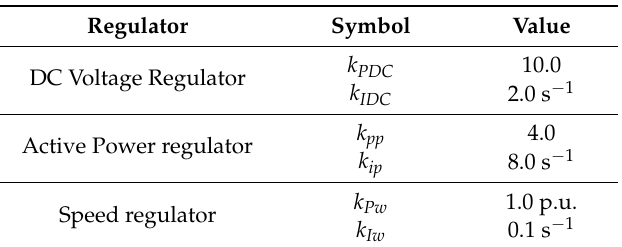
Table 3. Controller